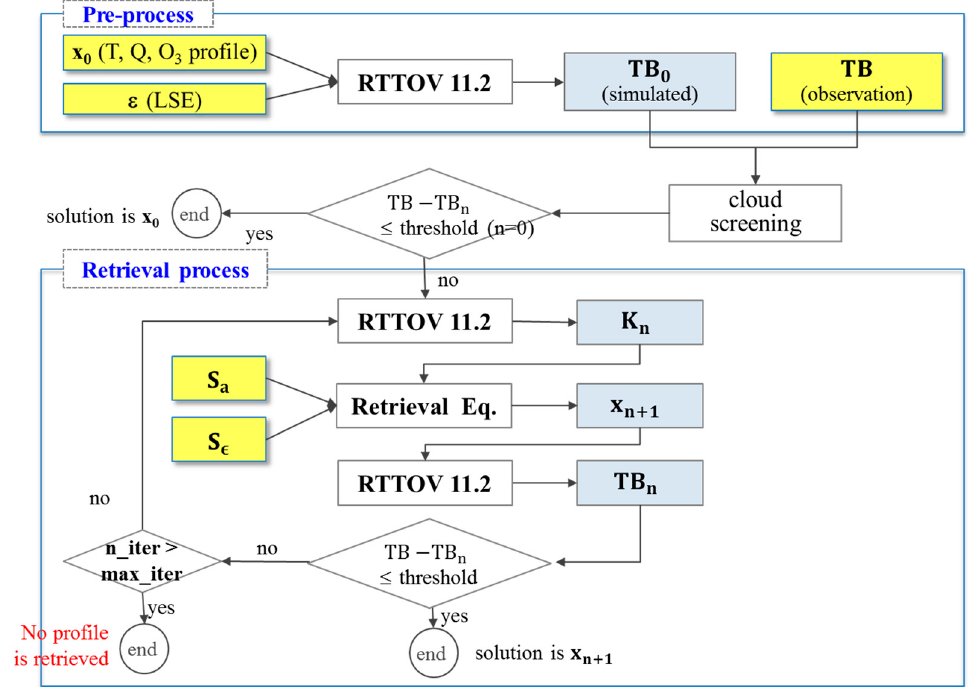
Figure 1. Algorithm flowchart for the retrieval of clear-sky atmospheric profiles.